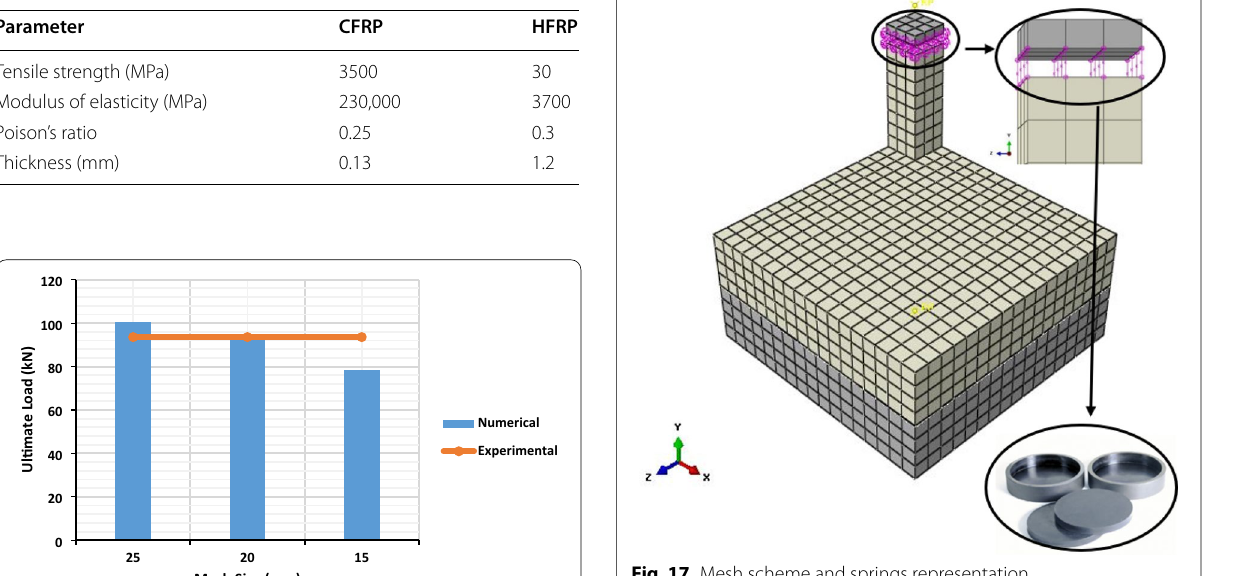
Fig. 17 Mesh scheme and springs representation.